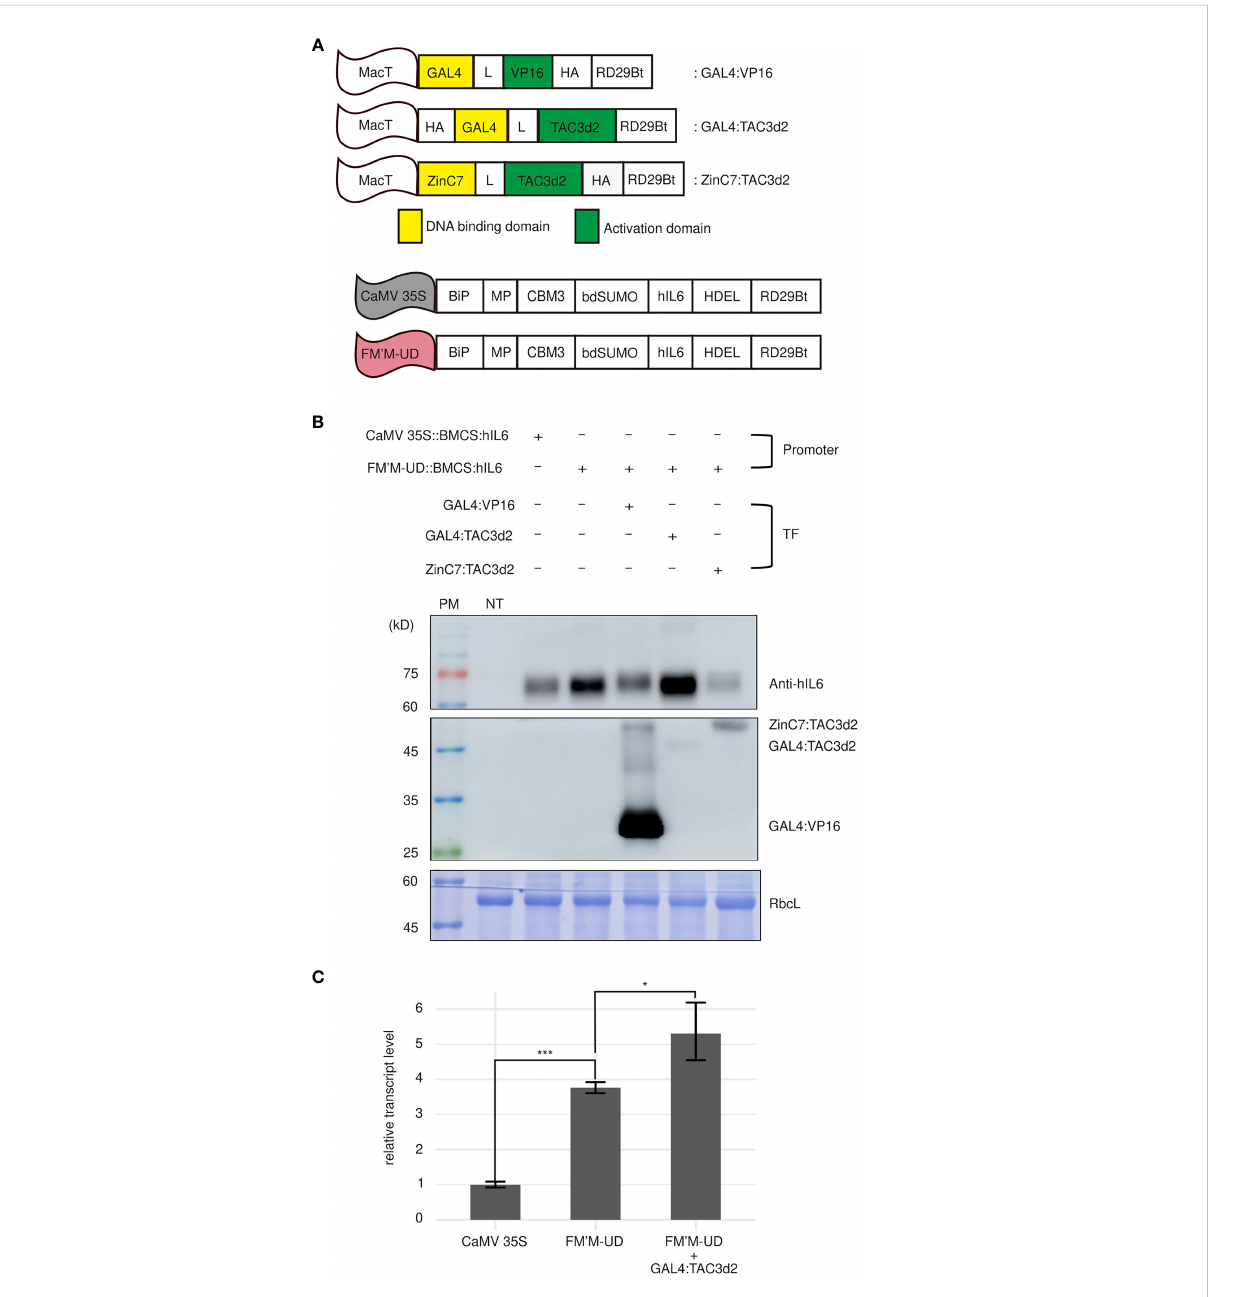
FIGURE 4 Arti fi cial trans -activator-mediated stimulation of transcription from the FM ′ M-UD promoter depends on the type of activator domains. (A) Schematic presentation of arti fi cial trans -activators used in this study. MacT is the promoter. DBDs are shown in yellow. HA: a small hemagglutinin tag used to detect the expression of arti fi cial transcription factors; MP: a fragment containing multiple N-glycosylation sites from the human protein tyrosine phosphatase receptor type C (CD45); CBM3: cellulose-binding module 3; bdSUMO: SUMO domain of Brachypodium ; hIL6: human interleukin 6; HDEL: an ER retention motif. (B) Expression levels of the reporter proteins and trans -activators. The indicated constructs were introduced into tobacco leaf cells by Agrobacterium - mediated in fi ltration. Total soluble proteins were prepared from leaf tissues harvested at 3 dpi and analyzed by western blotting using anti-hIL6 and anti-HA antibodies. (C) Comparison of the hIL6 transcript levels produced by the CaMV 35S, FM ’ M-UD promoters and/or arti fi cial transactivator GAL4:TAC3d2. A hygromycine resistant gene in the same vector was used as an internal control. The data shown are means ± SD (n = 3). Asterisks indicate statistically signi fi cant difference determined by two-tailed Student ’ s t -tests; *: P < 0.05; ***: P <